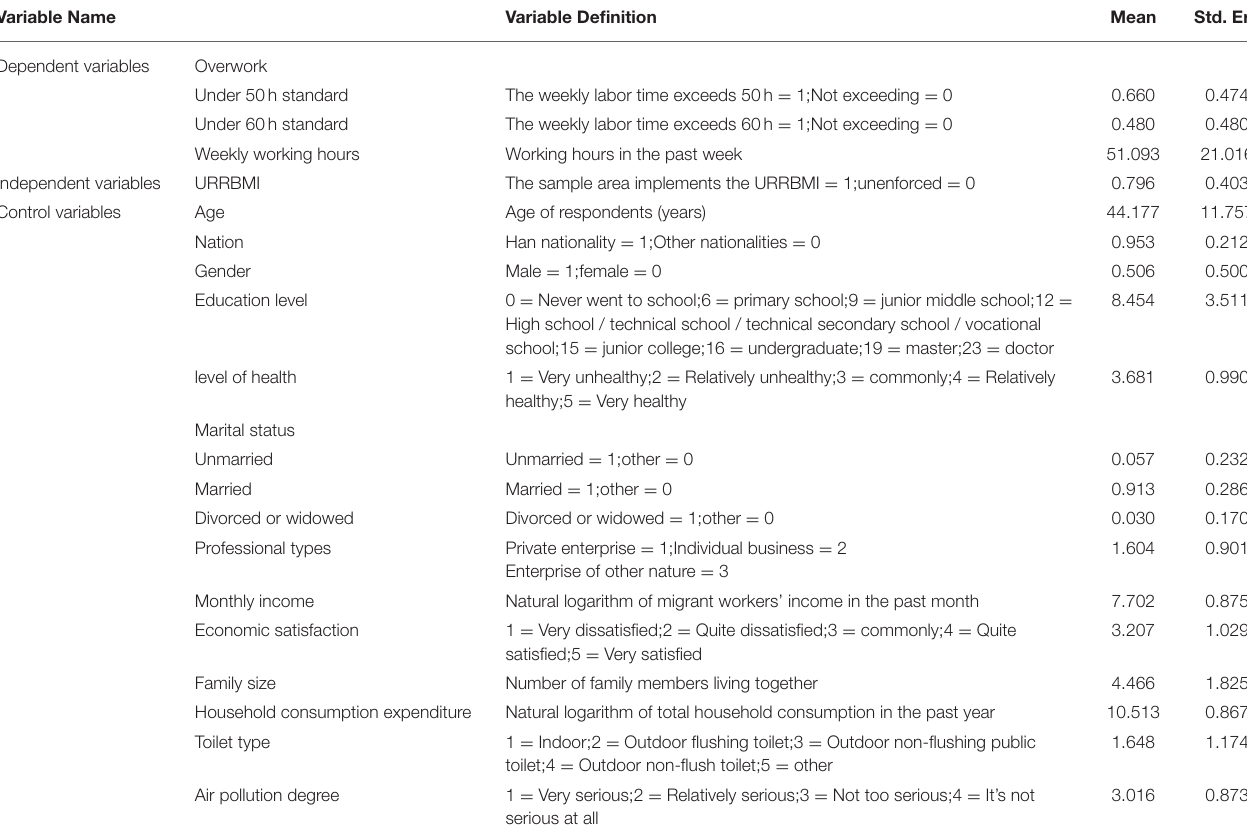
TABLE 2 | Definition and value of each